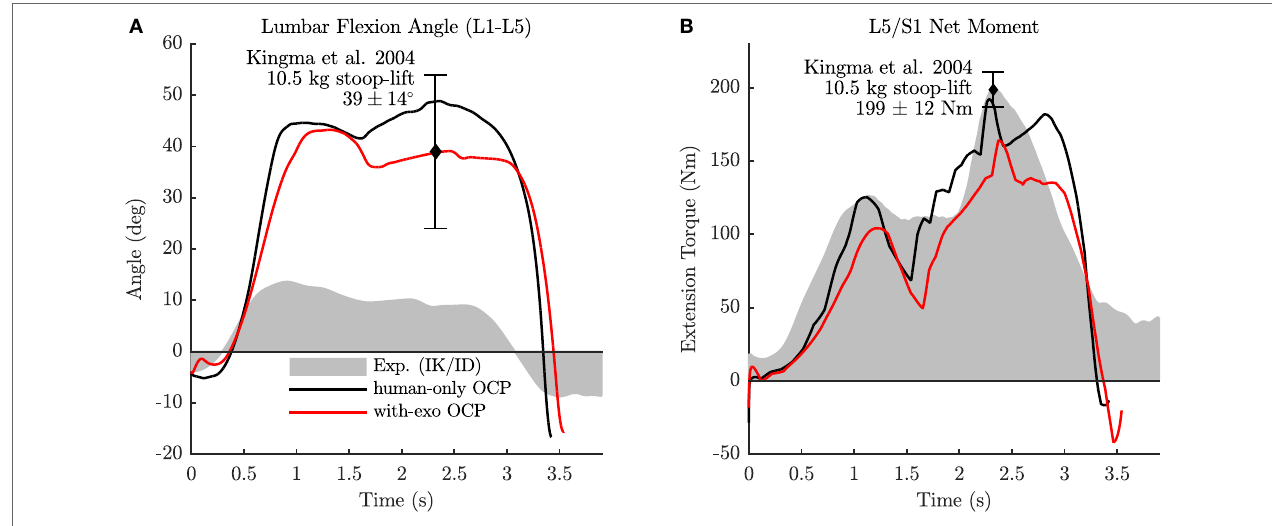
FIgURe 4 | The lumbar-flexion angle (a) and the L5/S1 net moment (b) for the inverse-dynamics analysis of the experimental subject, the human-only OCP, and the with-exo OCP. The exoskeleton reduces the model’s lumbar-flexion angle by 6° and the peak extension moment by 28